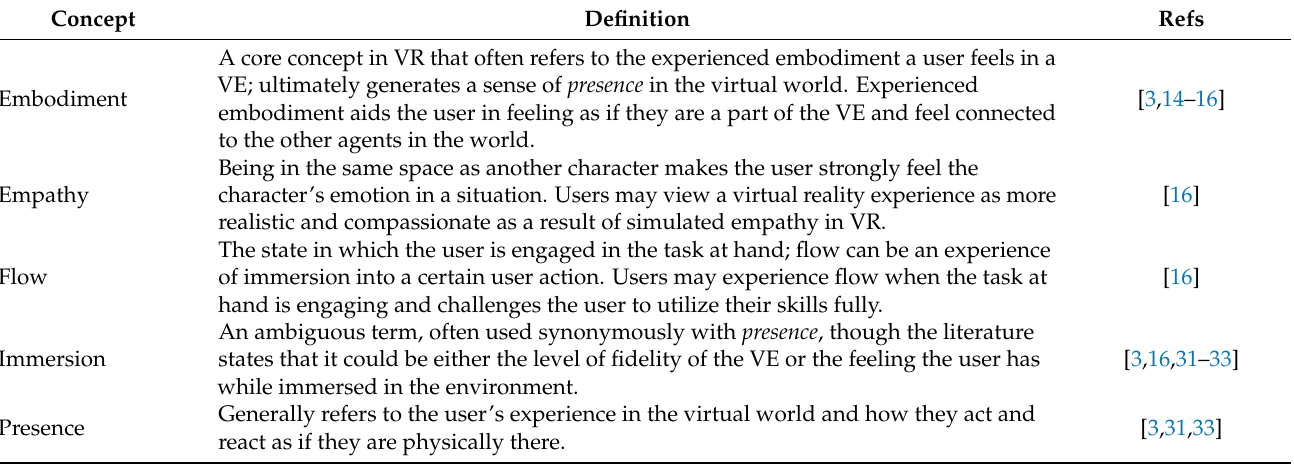
Table 2. Key identified concepts that are considered vital in a VLE